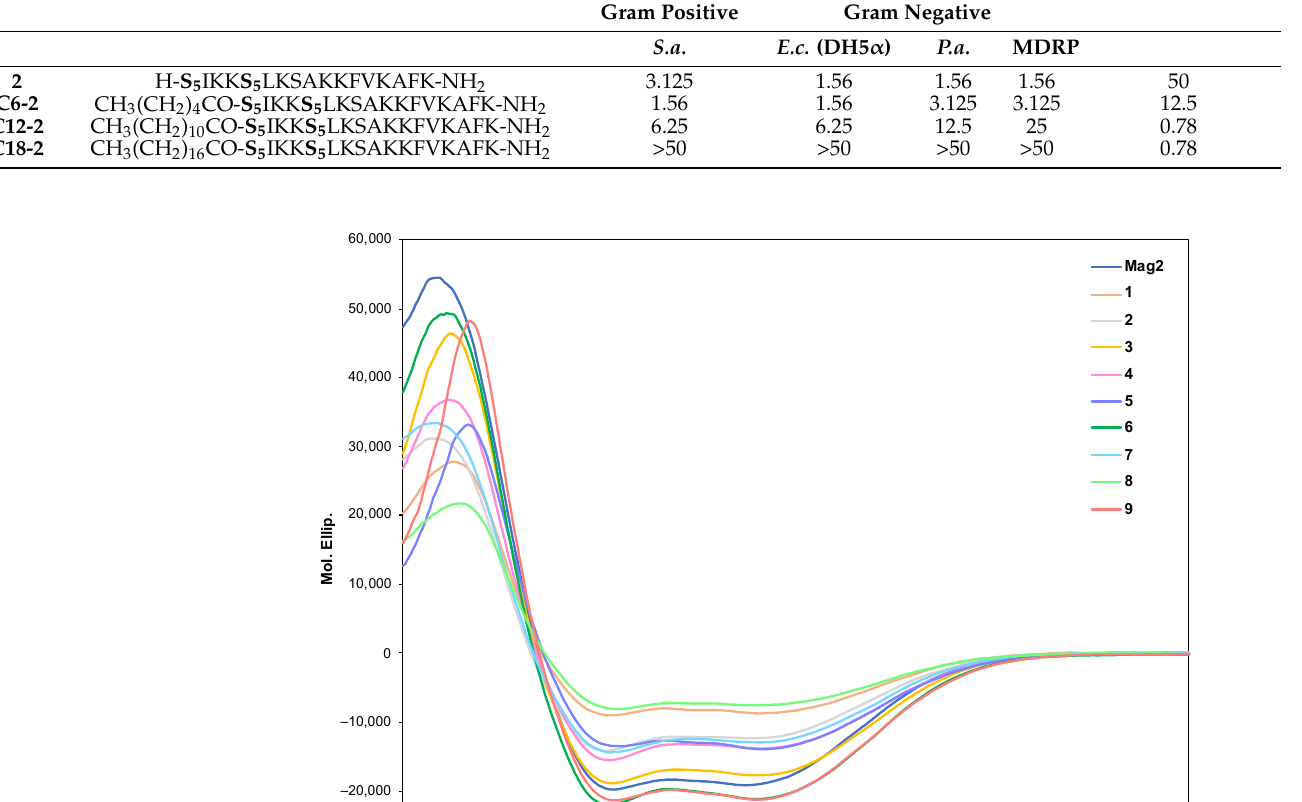
Table 2. Antimicrobial activity and hemolytic activity of N-terminal fatty acylated peptides. Peptide